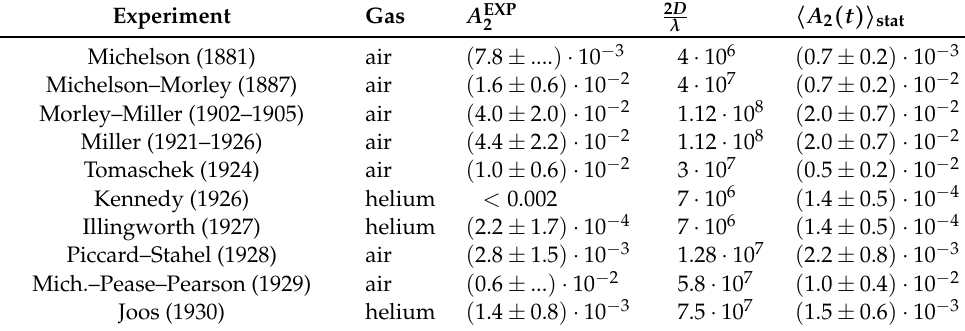
Table 1. The average second harmonic amplitudes of classical ether drift experiments. These were extracted from the original papers by averaging the amplitudes of the individual observations and assuming the direction of the local drift to be completely random (i.e., no vector averaging of different sessions). These experimental values are then compared with the full statistical average Equation (57) for a projection 250 km/s (cid:46) V | sin z ( t ) | (cid:46) 370 km/s of the Earth’s motion in the CMB and refractivities (cid:101) = 2.8 · 10 − 4 for air and (cid:101) = 3.3 · 10 − 5 for gaseous helium. The experimental value for the Morley–Miller experiment is taken from the observed velocities reported in Miller’s Figure 4, and our Figure 3. The experimental value for the Michelson–Pease–Pearson experiment refers to the only known session for which the fringe shifts are reported explicitly [66] and where the optical path was still fifty-five feet. The symbol ± .... means that the experimental uncertainty cannot be determined from the available information. The table is taken from ref.